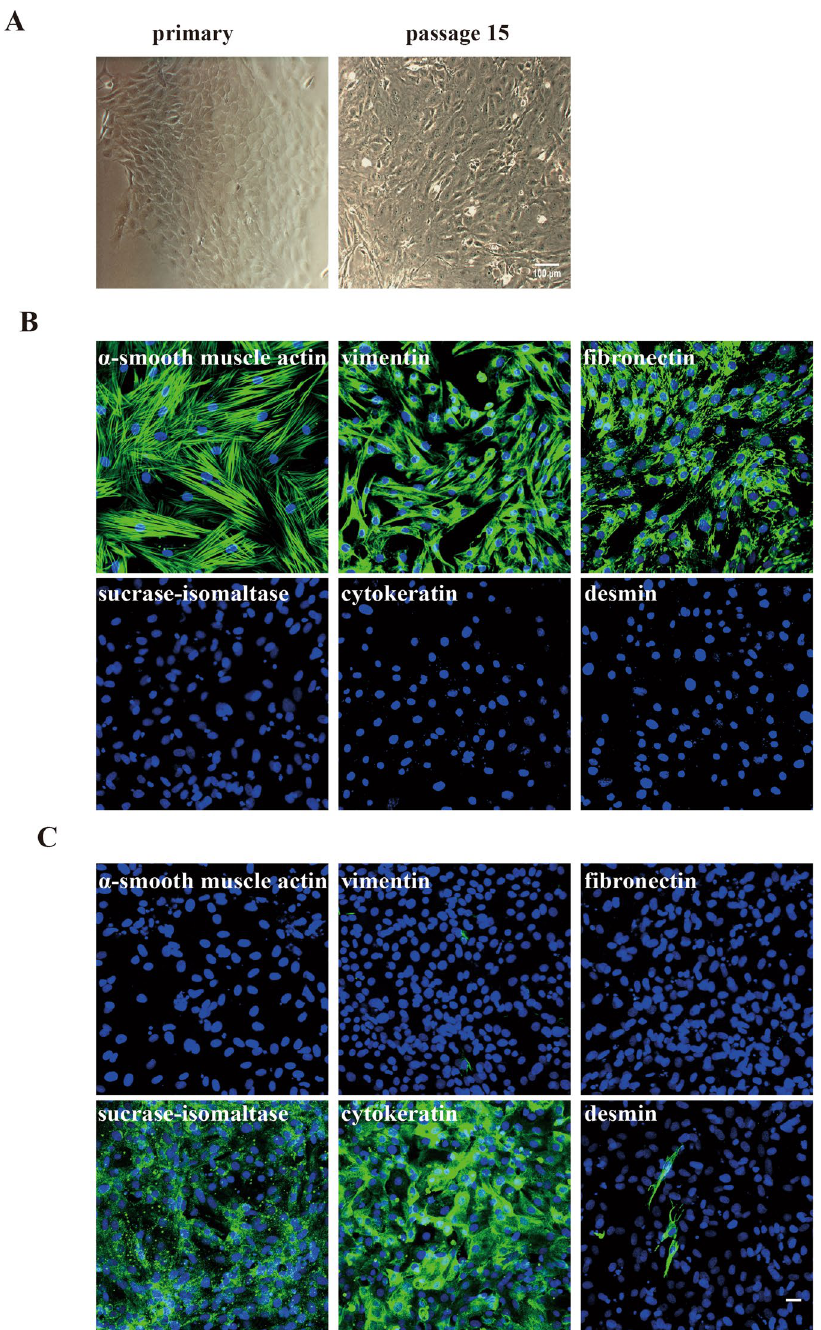
Figure 2. Morphological characterization of the myofibroblasts isolated from porcine ileum. ( A ) Characteristics of porcine ileum myofibroblasts. Myofibroblasts could be observed at 5 days after isolation. They had a cobblestone like morphology. They could be further sub- passaged as a continuous cell line. ( B ) A third passage of myofibroblasts was identified by immunofluorescence staining. Cells stained characteristically for intestinal myofibroblasts. They were positive for α -smooth muscle actin, vimentin and fibronectin, while cells were negative for sucrase-isomaltase, cytokeratin and desmin. ( C ) Primary ileum epithelial cells were used as control and stained with all markers that were used for the staining of the myofibroblasts. Scale bar: 25 µ